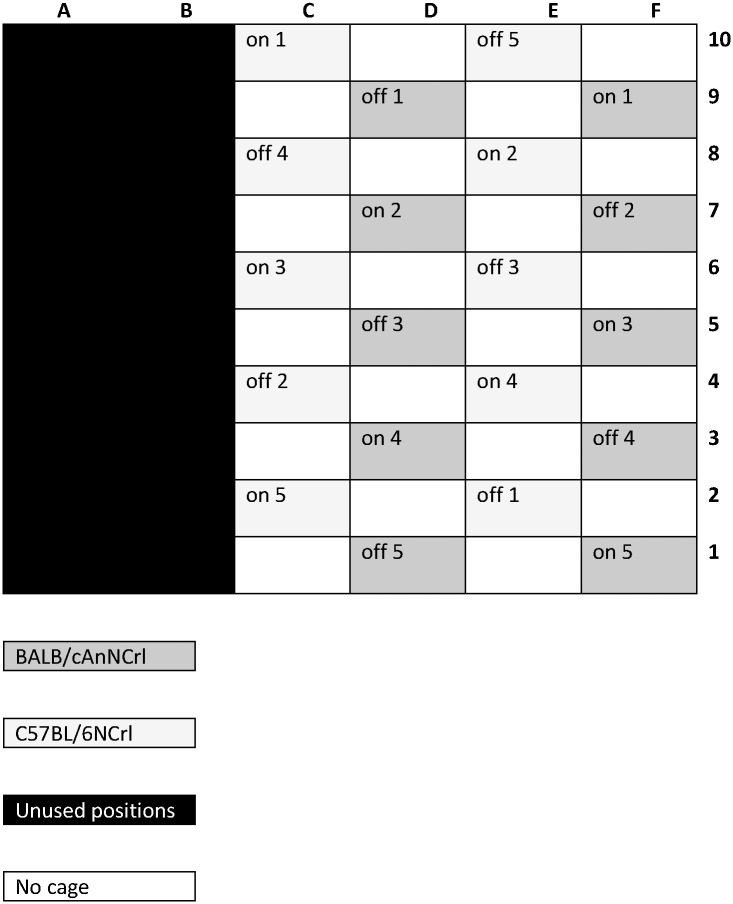
Representation of the cage allocation in the rack.EMF ‘on’ and ‘off’ cages are separated by empty spaces, with cage position balanced as far as possible for strain and treatment.